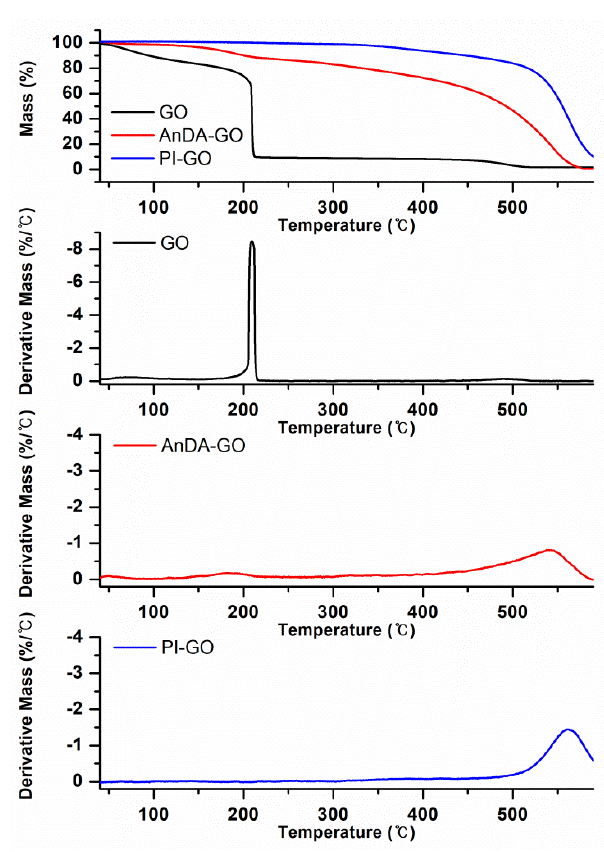
Figure 2. FT-IR spectra of ( a ) GO; ( b ) AnDA-GO and ( c ) PI-GO.